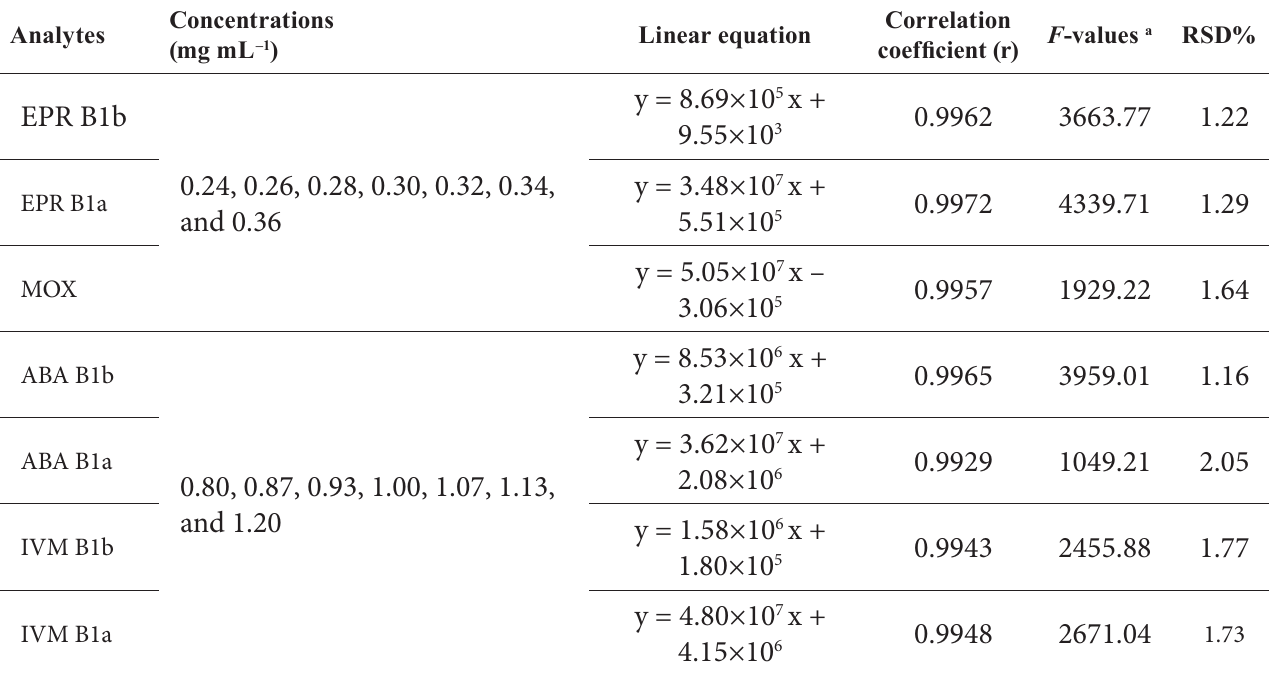
TABLE III - The linearity of the analytical curve